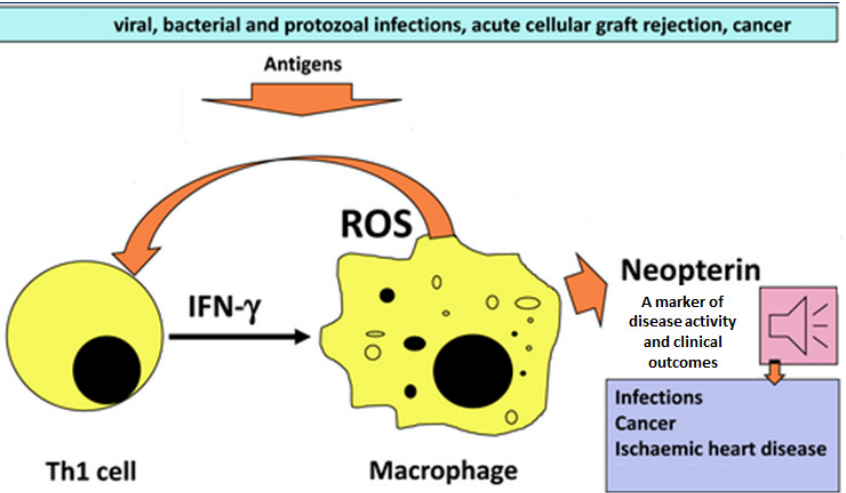
Figure 5. Neopterin (Nep) is involved in immune system activation and is a marker of disease activity in various inflammatory conditions. Nep, produced by activated macrophages in response to stimulation by interferon- γ , is a marker of immune activation